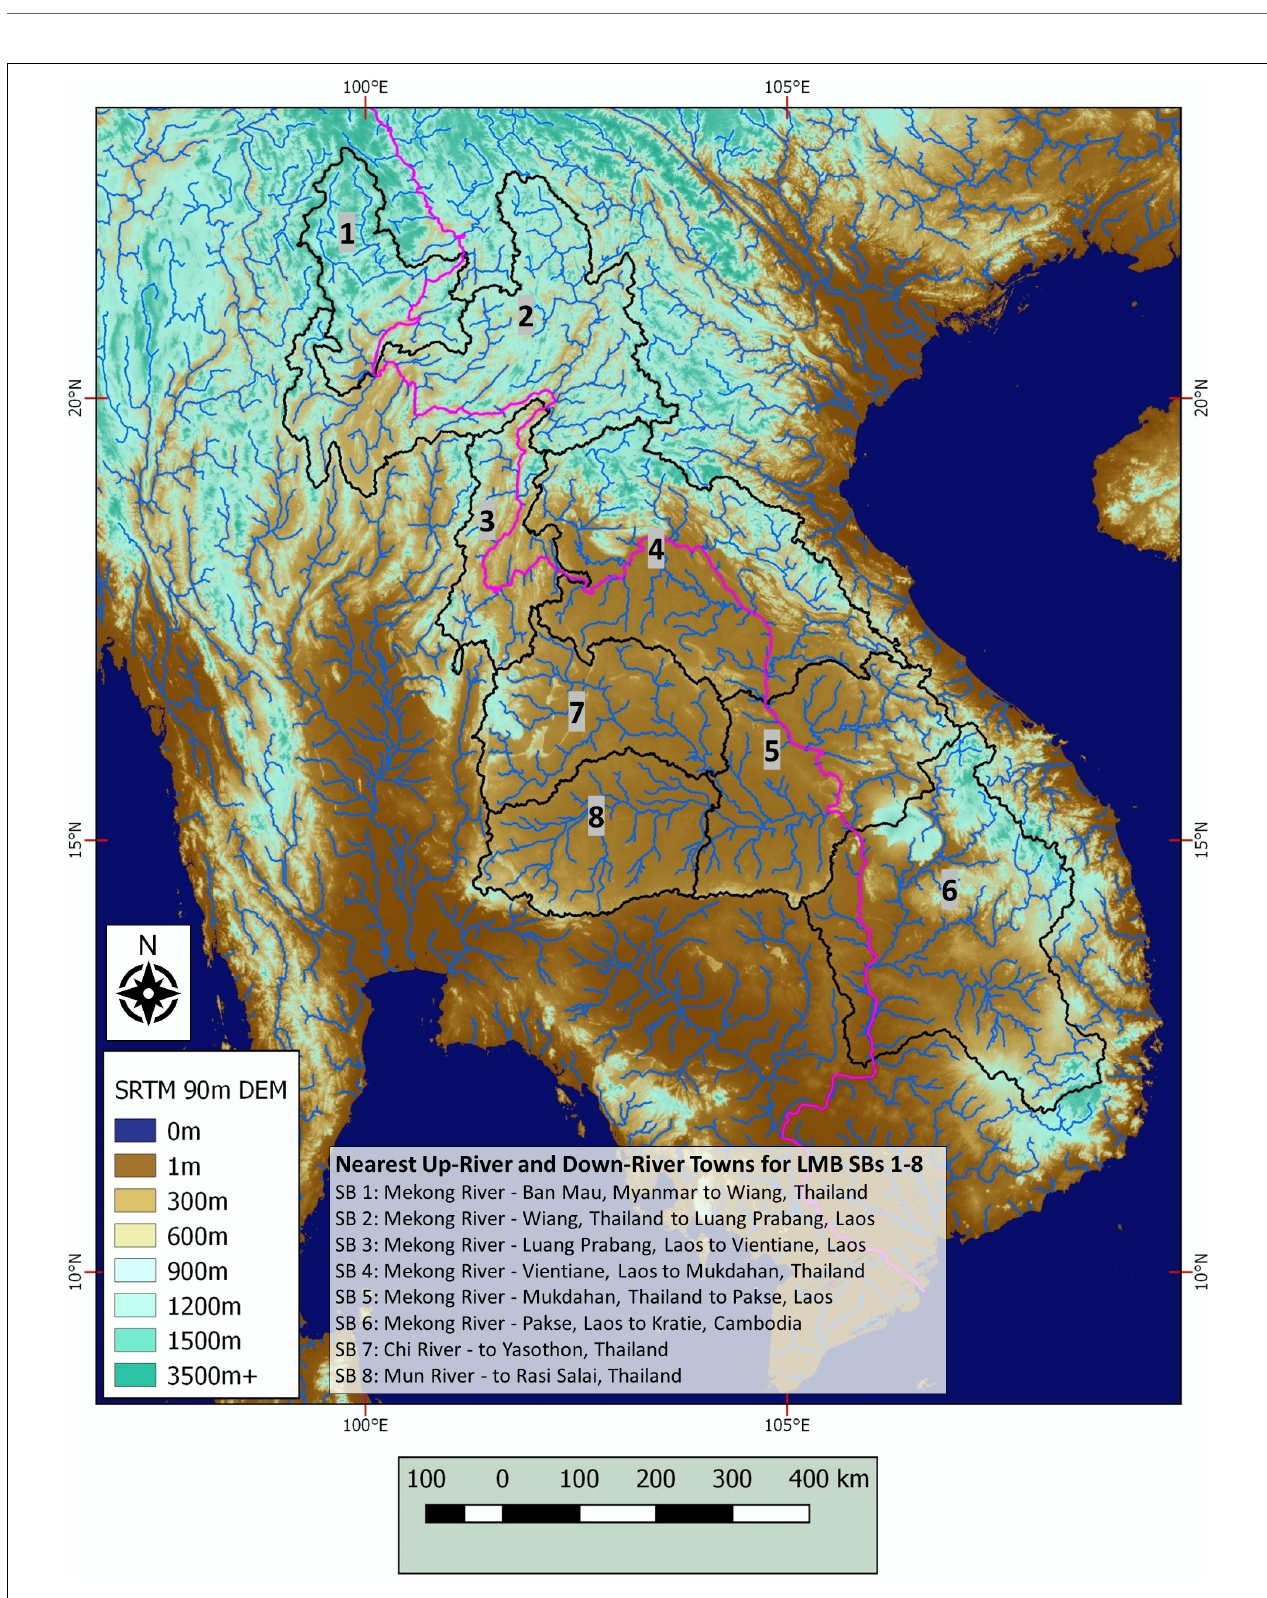
FIGURE 1 | Study area location in Lower Mekong Basin of southeast Asia with Sub-basins (SBs) 1–8 (in black) along with river boundaries (blue) overlain onto a colorized 90 m digital elevation model (DEM) from the NASA Shuttle Radar Topography Mission (SRTM). The main branch of the Mekong River is shown in a magenta tone and the SB #s are included as black